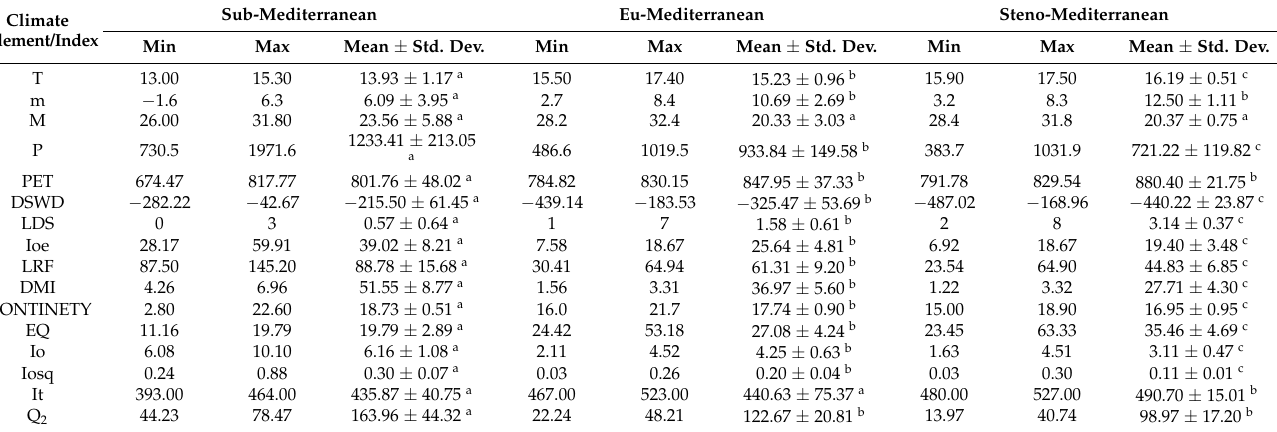
Table 3. Descriptive statistics and comparison of bioclimatic parameters and indices in the area of different vegetation zones in forest stands of the Mediterranean vegetation belt on the eastern Adriatic